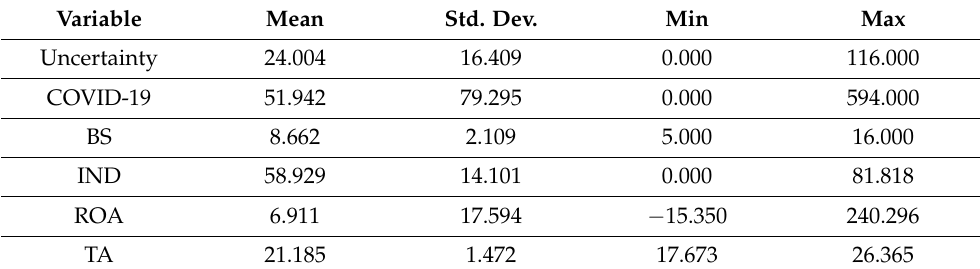
Table 2. Descriptive Statistics.